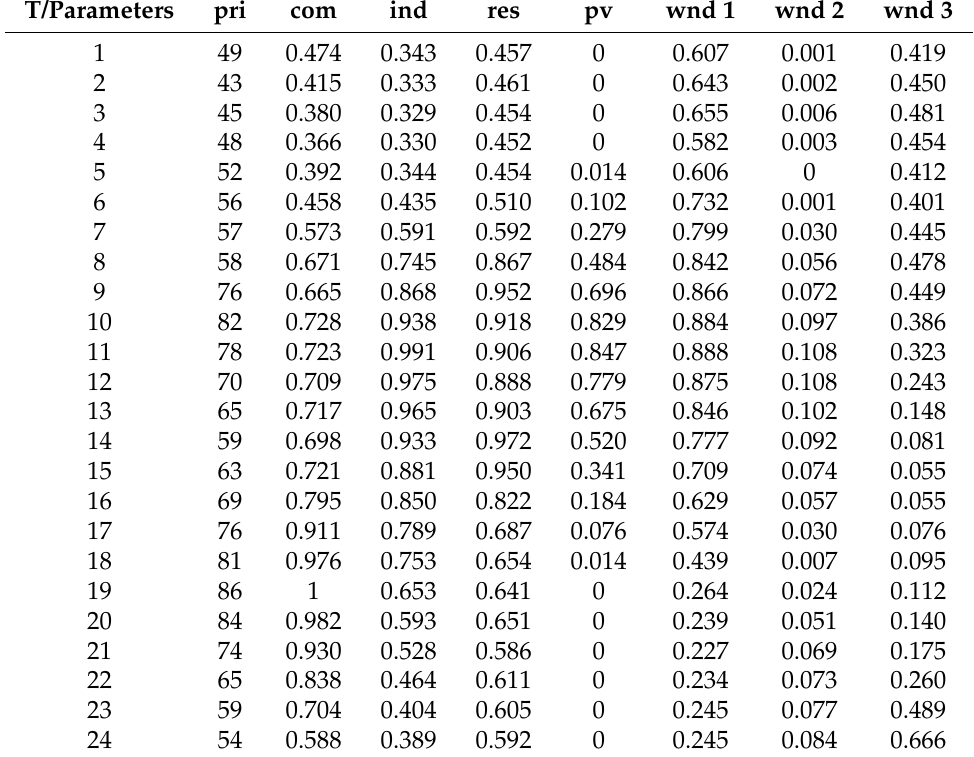
Table A7. Table representing the parameters regarding price in energy market, demand profiles and